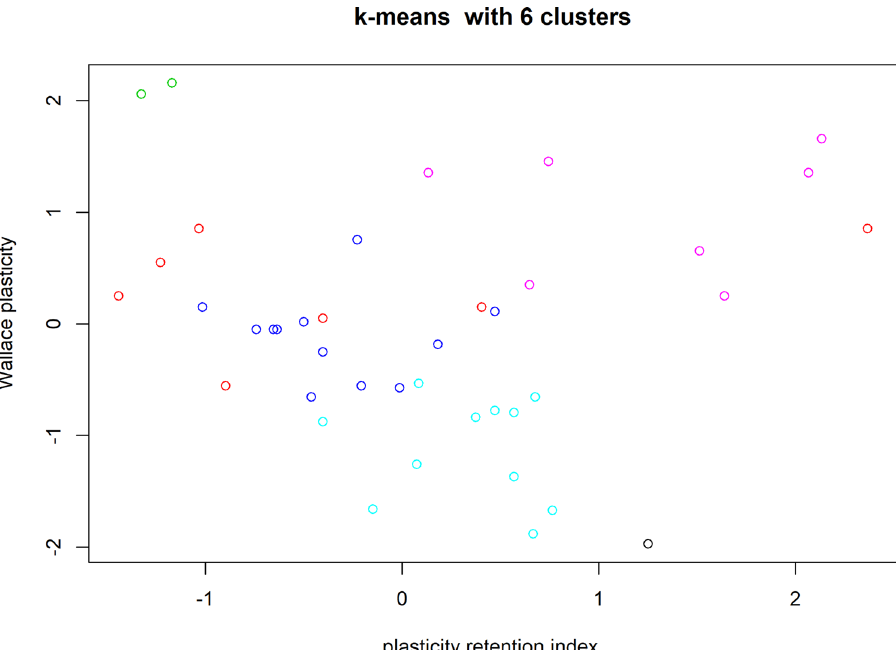
Figure 3. K-means analysis of analysis of data on technological properties of natural rubber, used in the evaluation of the 44 rubber tree genotypes. Axes represent the first two components (Comp 1 and 2). Each dot represents an individual. The colors represent different clusters identified by the analysis. From left to right: cluster V is shown in green and comprises IAC 402 and IAC 407, cluster III is shown in red and comprises Asiatic genotypes (PB 291, PB 314, PB 355, PC 119, PM 10, RRIM 713, RRIM 937, and RRIM 938), cluster I is shown in blue and comprises IAC genotypes except members of the IAC 500 series. Cluster VI is shown in aqua and it is formed by the other genotypes from Asia (PB 311, PB 312, PB 324, PB 350, RRIM 901, GT1), cluster IV is shown in black and includes only PB 326, and cluster II is composed of the IAC 500